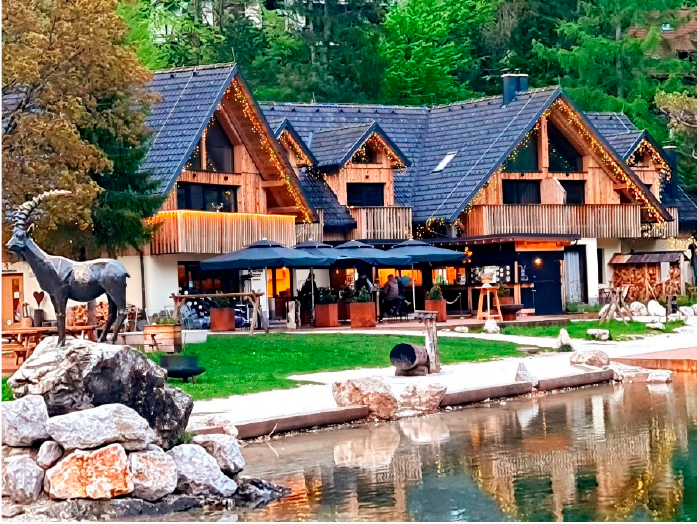
Figure 2. Jasna Chalet Resort by the lake Jasna, Slovenia: http://jasnaresort.com/en/ (accessed on 22 June 2022).